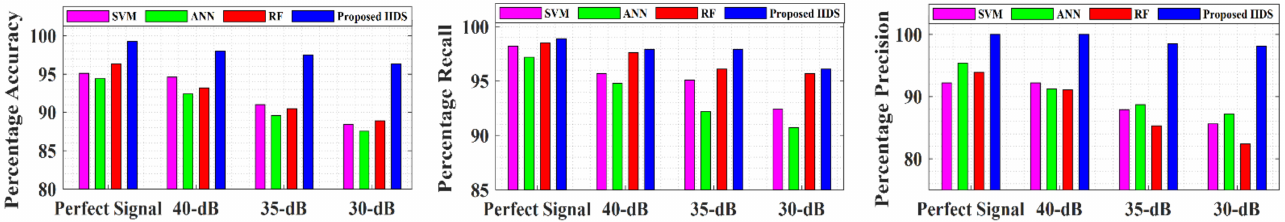
Figure 6. Effect of noisy measurement on islanding detection